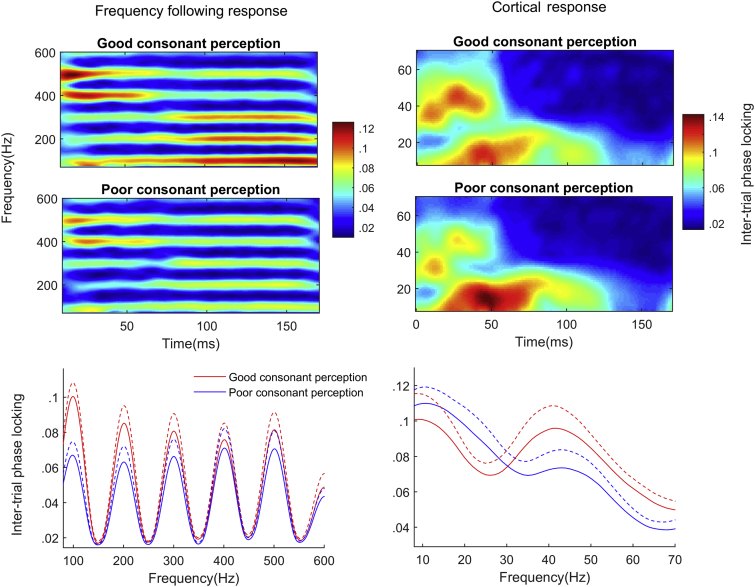
(Left, top) Time–frequency plot of inter-trial phase locking for the frequency following response for participants with good versus poor perception of English consonants. Participants were divided into top and bottom halves based on performance on the consonant portions of the receptive phonology test. (Right, top) Time–frequency plot of inter-trial phase locking for the cortical response for good versus poor consonant perceivers. (Left, bottom) Inter-trial phase locking in the frequency following response as a function of frequency across the entire response (10–170 msec) for good (red) versus poor (blue) consonant perceivers. Error bars are one standard error of the mean. (Right, bottom) Inter-trial phase locking in the frequency following response as a function of frequency across the first 60 msec of the response for good versus poor consonant perceivers.